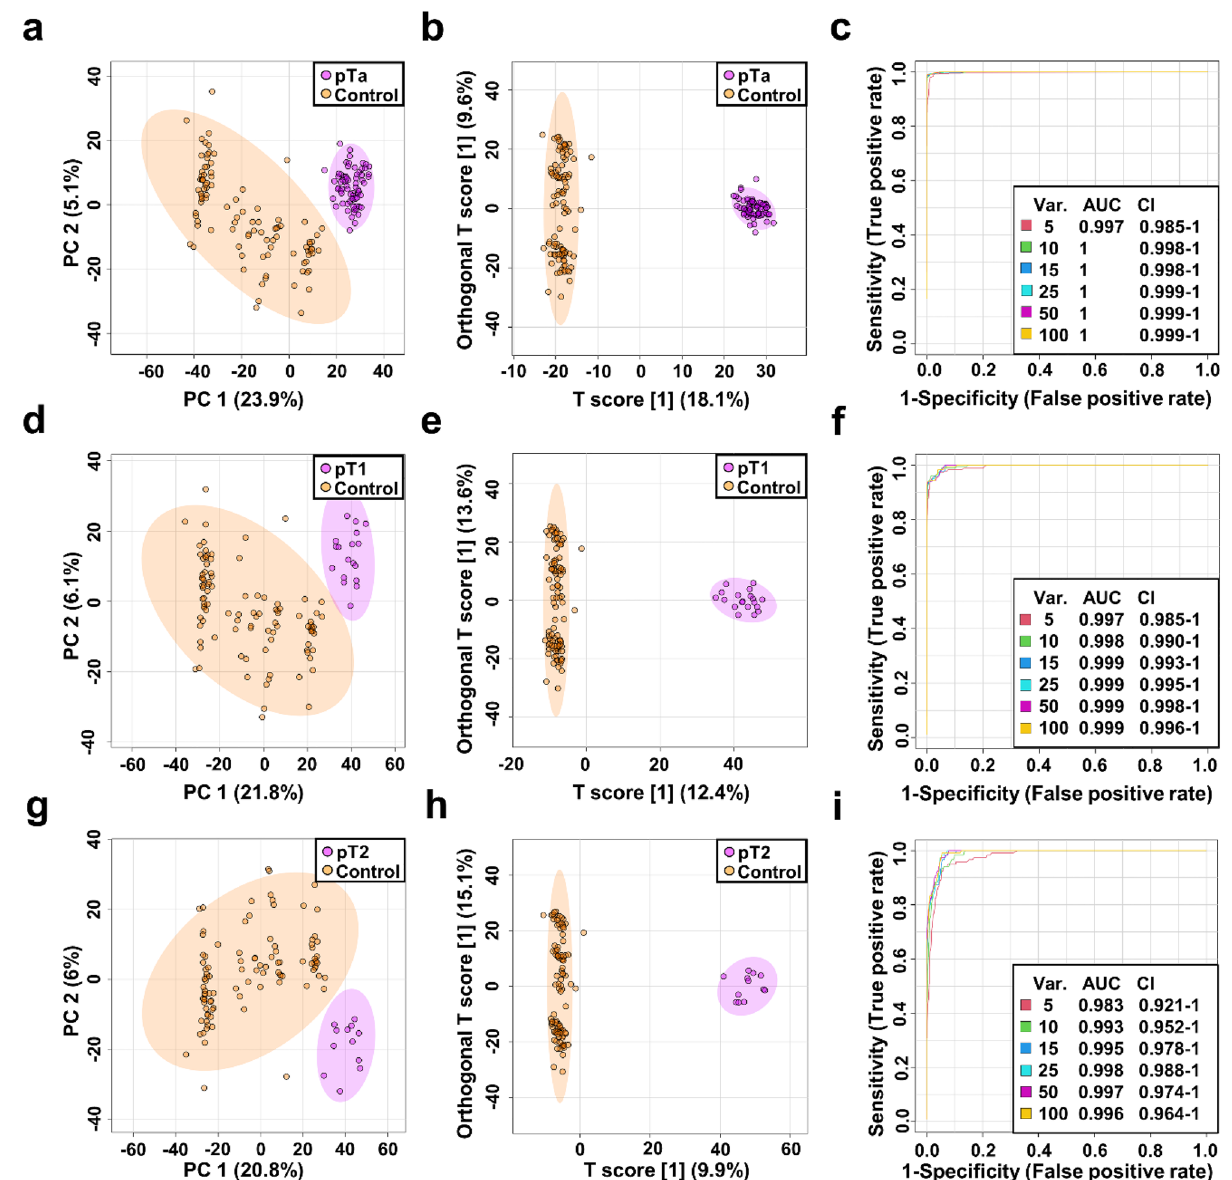
Figure 3. Metabolomic differentiation between different stages of BC and NCs. PCA ( a ), OPLS-DA ( b ) scores plots and ROC curve ( c ) of the pTa (violet) and control (orange). PCA ( d ), OPLS-DA ( e ) scores plots and ROC curve ( f ) of the pT1 (violet) and control (orange). PCA ( g ), OPLS-DA ( h ) scores plots and ROC curve ( i ) of the pT2 (violet) and control